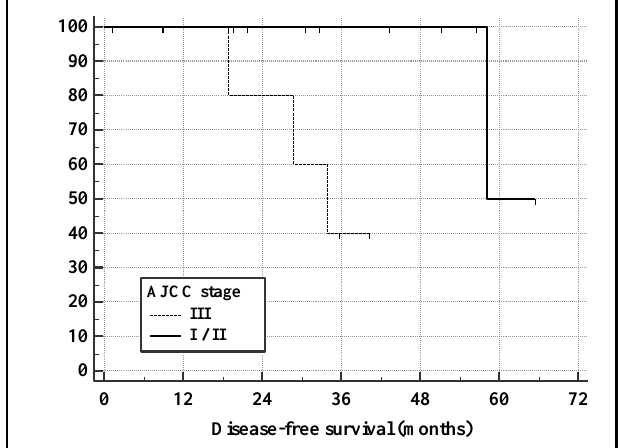
Figure 5: Kaplan-Meier disease-free survival curves according to the American Joint Committee on Cancer (AJCC) staging